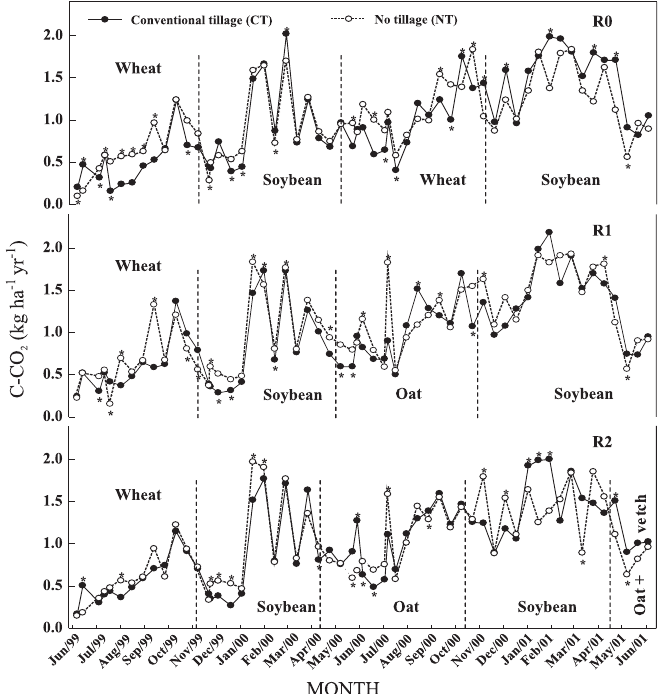
Figure 4. C-CO fluxes under conventional tillage (CT) and no tillage (NT) and cropping systems (R0: soybean/ 2 wheat; R1: soybean/wheat/soybean/black oat; R2: soybean/black oat/soybean/black oat+common vetch/ maize/radish oil/ wheat) during 07/June/99 to 04/June/01. * = means statistically different by LSD test (p <